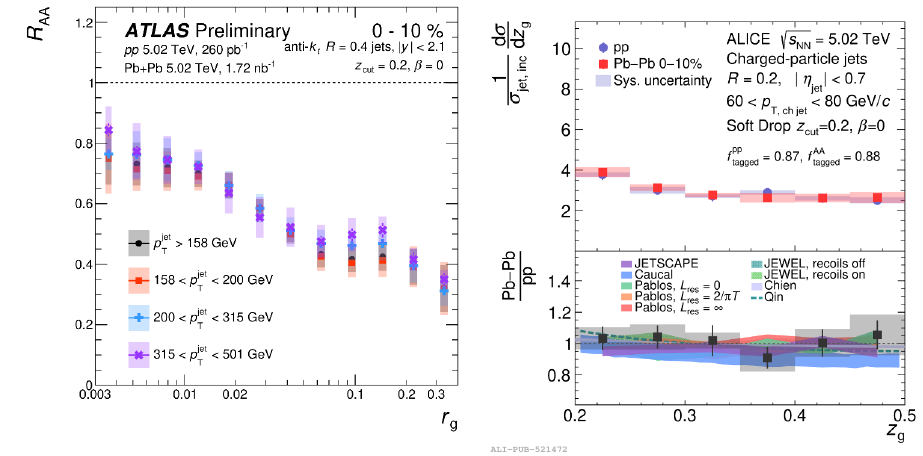
Figure 5. Left: The R AA as a function of the groomed jet radius r g in central 0-10% Pb–Pb collisions measured by ATLAS [21]. Right: The groomed jet momentum splitting fraction z g for R = 0 . 2 jets in central 0-10% Pb–Pb collisions and pp collisions measured by ALICE